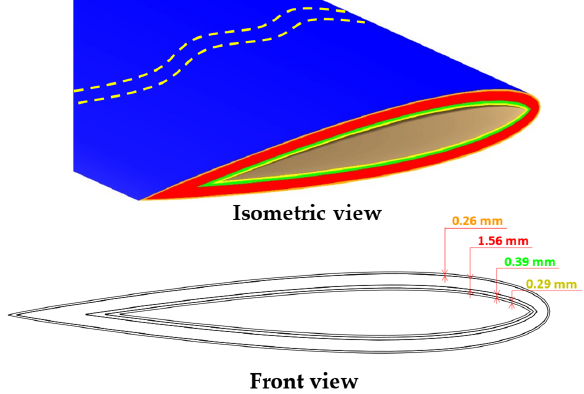
Figure 15. Illustration of the partition zones of the blade.